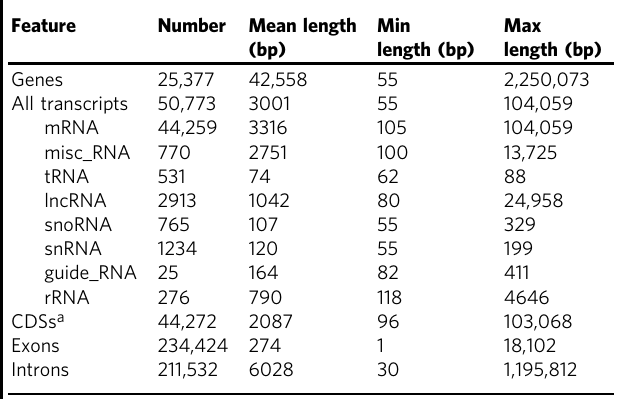
Fig. 1 The Hi-C contact map of the assembled American mink genome. The blue squares represent the 15 chromosomes of American mink. The color bar at the right represents the density of Hi-C interactions.